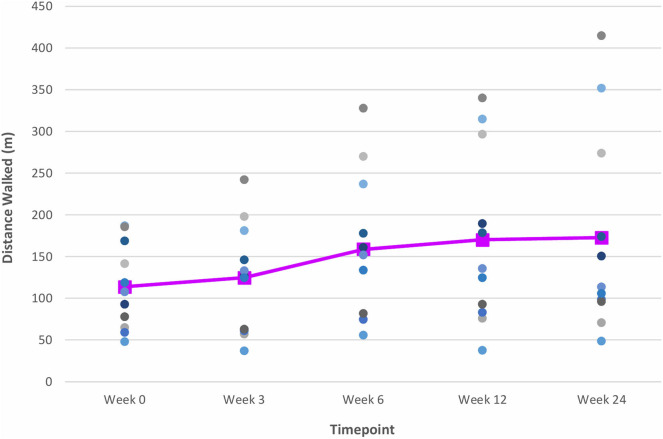
Time series plot showing the primary outcome measure of distance walked (as measured by the 6 MWT). Each circle • represents a study subject. A trend line (–) has been superimposed to illustrate the change in the mean ± SD distance walked from baseline pre-intervention (i.e., Week 0) to final follow-up post-intervention (i.e., Week 24).